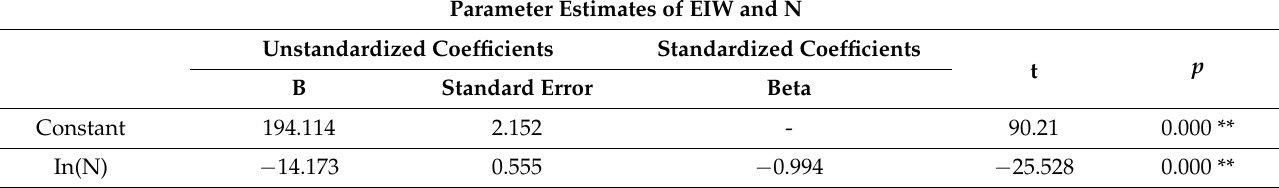
Table 4. Parameter Estimates of EIW and